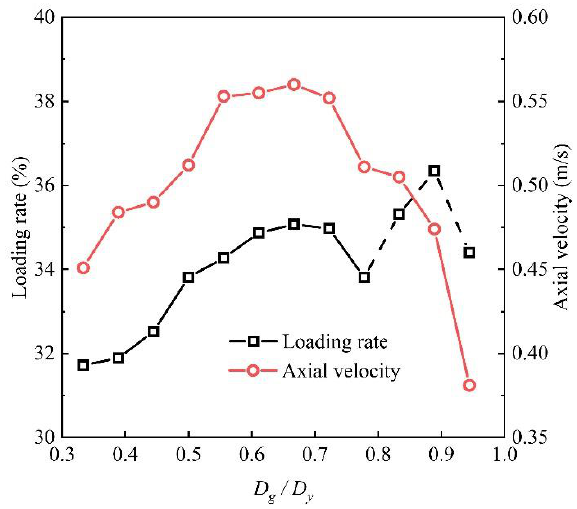
Figure 17. Loading rate and particles’ axial velocities versus barrel diameter in pushing mode ( D y = 900 mm).